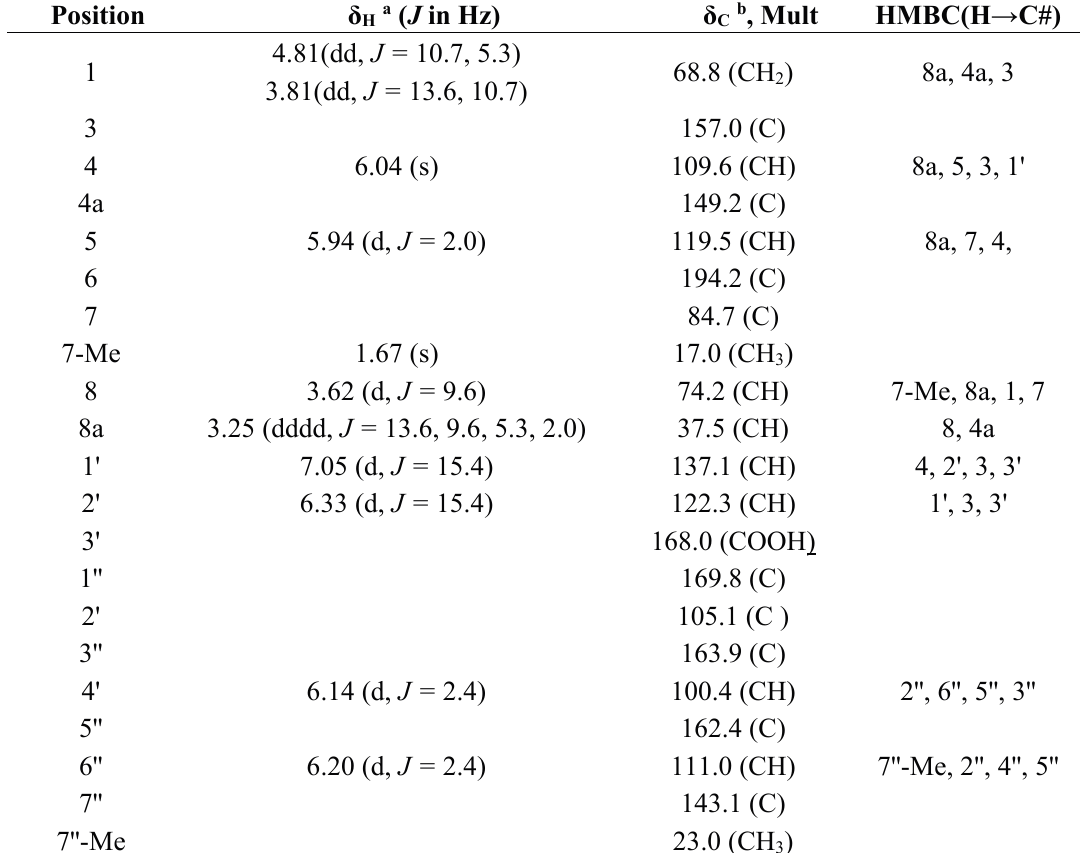
Table 2. NMR Spectroscopic Data for Compound 2 (Pinophilin C) in CD 3 OD- d 6